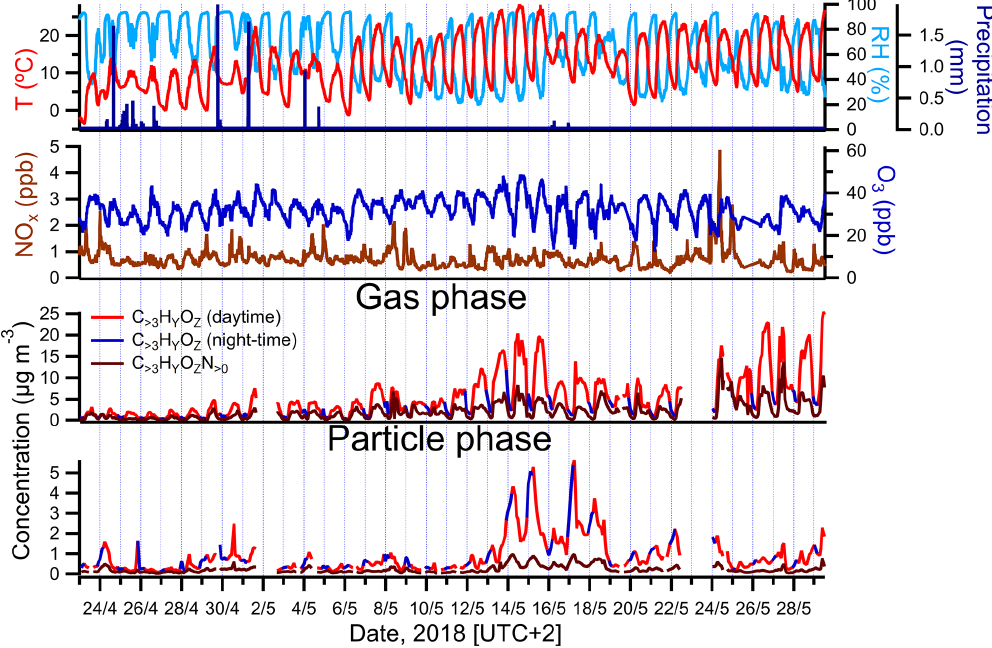
Figure 2. Campaign-spanning comparison between concentrations of larger oxygenated organics measured in the gas and particle phases by FIGAERO-CIMS and colored by time periods of the day (daytime is indicated in red; nighttime is in blue). The evolution of air tempera- ture, RH, precipitation, ozone (O 3 ) and nitrogen oxides (NO x = NO + NO 2 ) is shown as